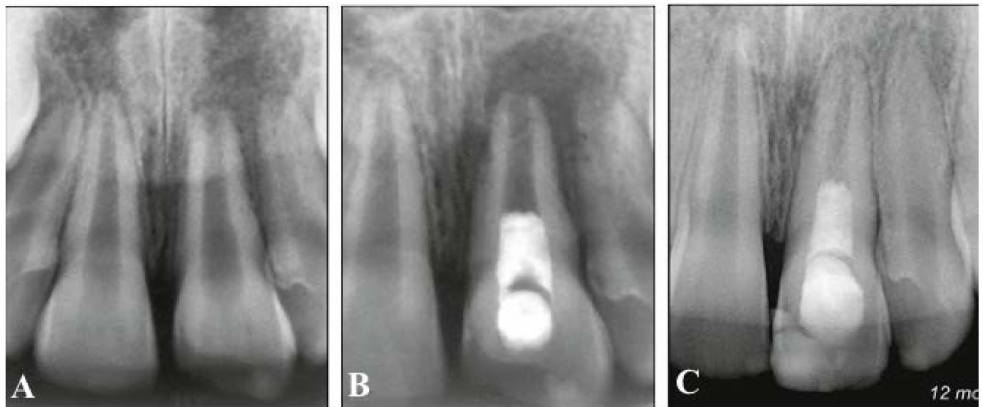
Figure 1. Radiographs of revascularized human immature permanent tooth #9. ( A ) Preoperative radiograph to show inflammatory periapical lesion; ( B ) Postoperative radiograph after regenerative endodontic procedures; ( C ) At 12-month follow-up, thickening of the canal walls and continued root maturation [54].